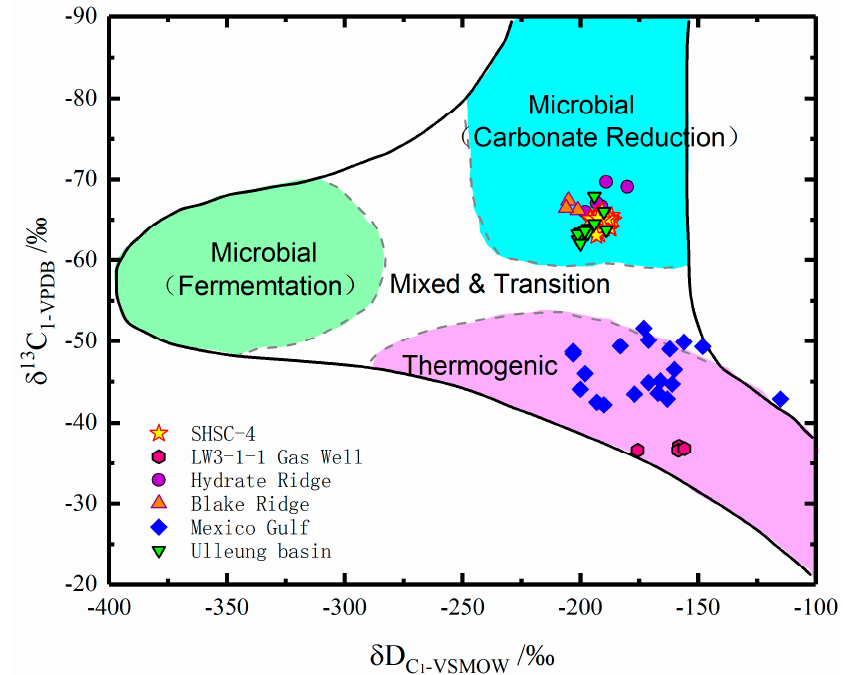
Figure 5. Relationship between δ 13 C and δ D of CH 4 from China’s first offshore gas hydrate production test in SCS (base map from Whiticar et al. [6]). The data from the LW3-1-1 gas well in SCS [15], the Hydrate Ridge [16], the Blake Ridge [11], the Mexico Gulf [12], and the Ulleung Basin [14] were plotted for comparison.